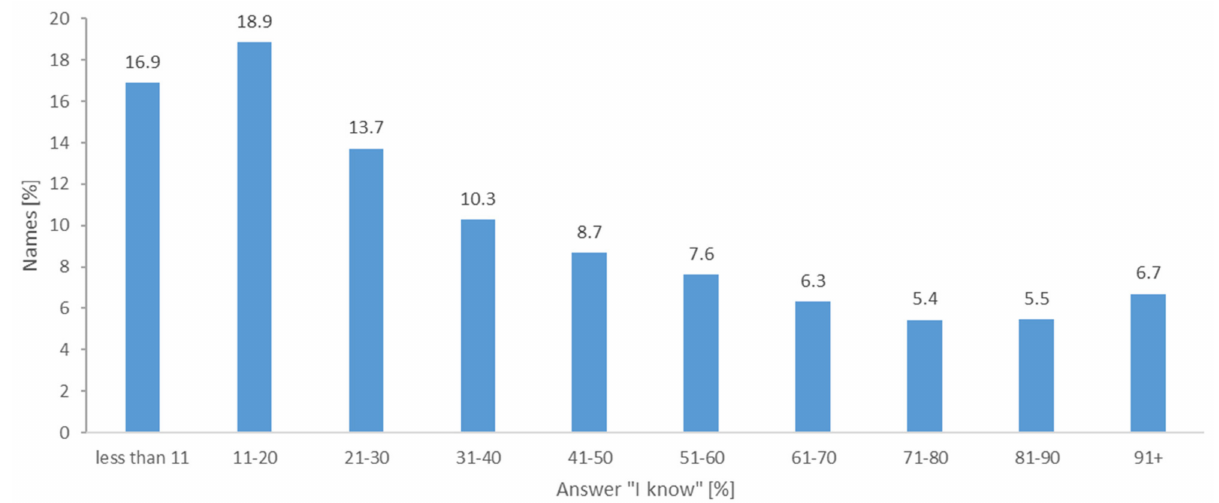
Figure 6. The level of knowledge of names (number of names =